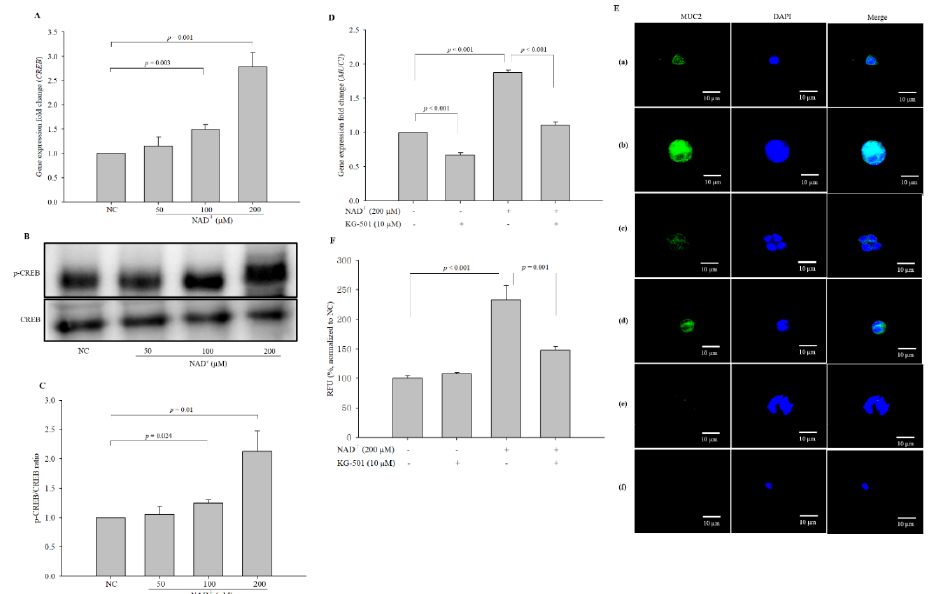
Figure 9. Cyclic AMP (cAMP) response element-binding protein (CREB) acts as a transcription factor to stimulate the expression of MUC2 upon exogenous NAD + administration. The effect of NAD + on the expression of CREB was measured by qPCR ( A ). The protein levels of CREB and phosphorylated CREB were assessed by Western blot analysis ( B ), and the p-CREB/CREB ratio was obtained ( C ). The blots are representative of three independent experiments. KG-501 was used to inhibit CREB activity, and MUC2 expression was measured at the gene level by qPCR ( D ) and the protein level by ICC (magnification 600×) ( E ). To clarify that the secondary antibodies were not affected by the generation of a fluorescence signal, the preparations of the negative control and 200 µ M NAD + -treated cells were created by omitting the primary antibody. ( a ) Negative control, ( b ) 200 µ M NAD + , ( c ) 10 µ M KG-501, ( d ) 200 µ M NAD + and 10 µ M KG-501, ( e ) negative control without the primary antibody, ( f ) 200 µ M NAD + without the primary antibody. The fluorescence intensity was quantified ( F ). The data are expressed as the mean ± standard SD of three independent experiments performed in triplicate. The symbols + and − indicate chemical treatment and non-treatment,